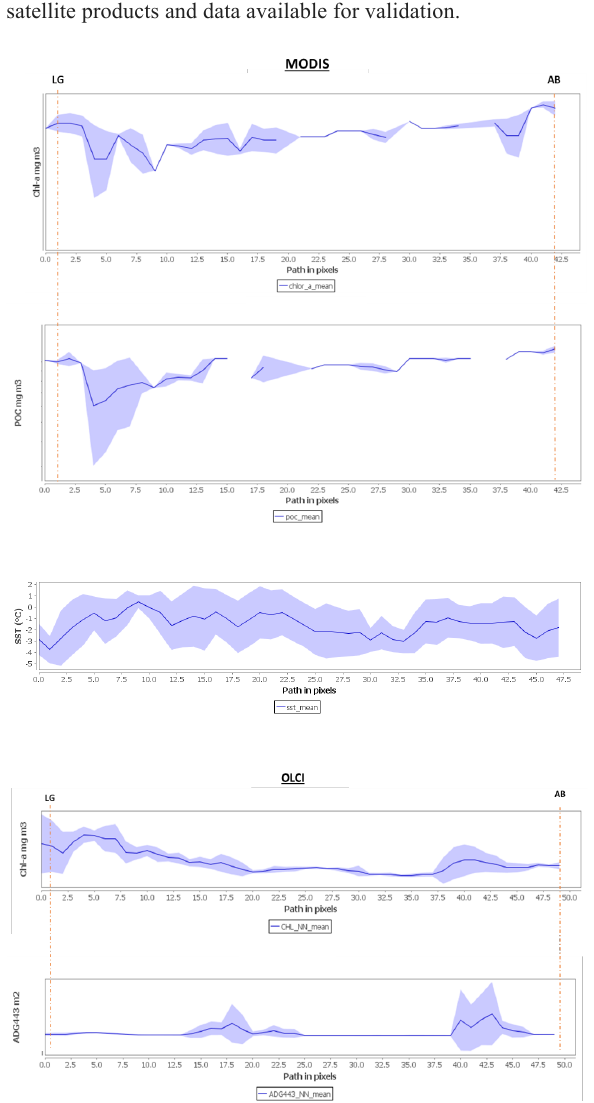
Figure 9. Spectral profiles between the front of LG and the exit of AB (MODIS and